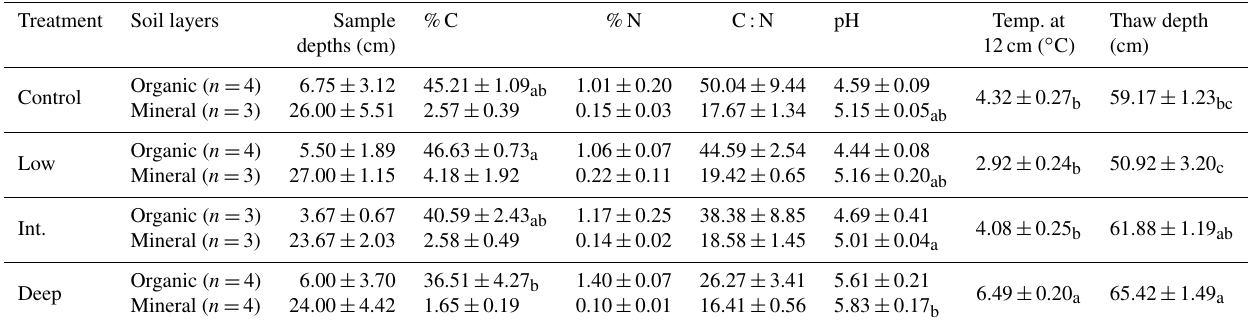
Table 1. Abiotic characteristics of soil from snow accumulation treatments (Low =∼ 25% less snowpack than the Control, Int. =∼ 50% more snowpack than the Control, Deep =∼ 100% more snowpack than the Control). Values are means ± standard errors. Soil chemical properties were obtained from samples used for DNA extraction, while temperature and thaw depth were measured in situ ( n = 12). Organic and mineral samples were analysed separately using the Nemenyi post hoc test. Results are indicated by subscripts “a”, “b”, or “c” only where p < 0.05.